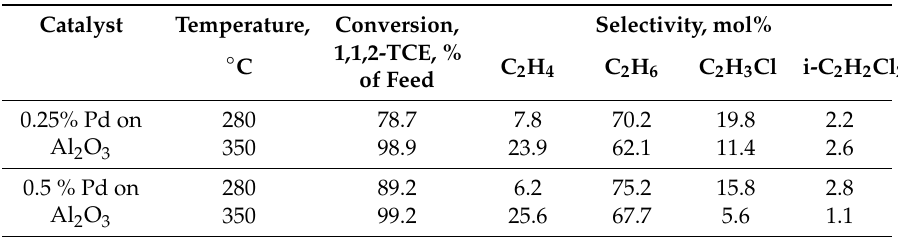
Table 9. Activity and selectivity of various catalysts in 1,1,2-trichloroethane